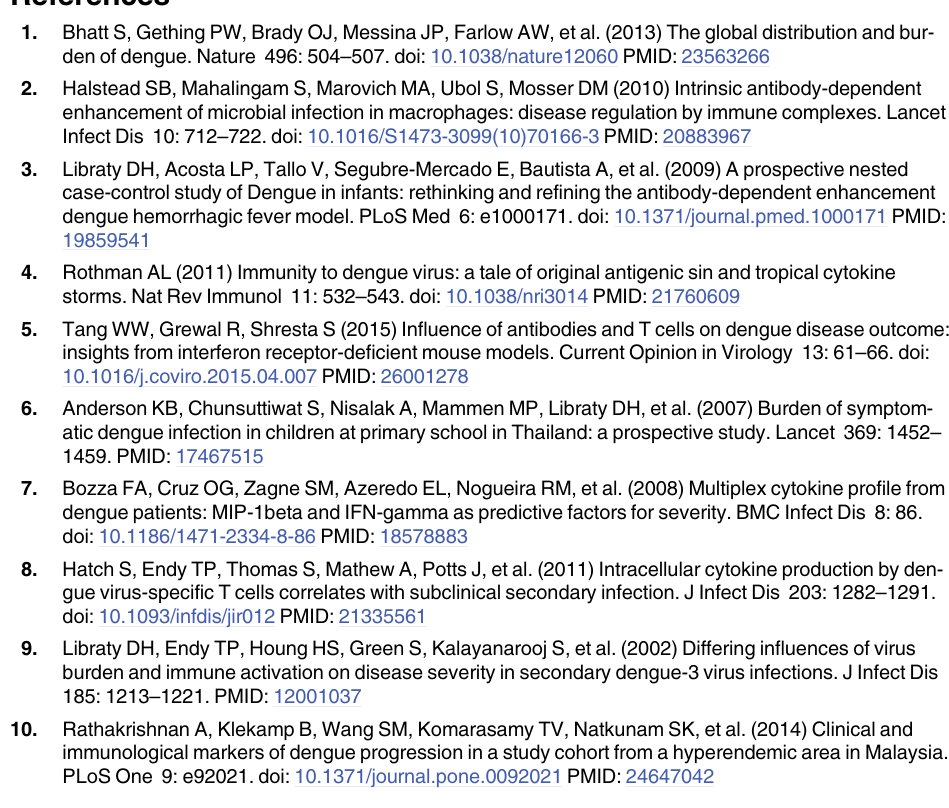
S8 Fig. Analysis of markers of severity in non-survivors. Comparison of DEN viremia (A), IL-6 (B), IL-8 (C), IL-10 (D), MCP-1 (E) and TNF- α (F) between severe dengue patients who succumbed to infection (n = 6) and the ones who survived (n = 40). Bars indicate geometric mean in (A) and median in (B-F). P values were estimated by Mann-Whitney test. (EPS) S9 Fig. Indicators of recovery from severe dengue. Paired line graph indicating IL-8 (A) and IL-10 (B) plasma levels in DENV patients with severe disease at the time of admission (bleed 1) who showed clinical recovery two or three days later (bleed 2) (N = 17). The indicated P values were determined by Mann-Whitney test.